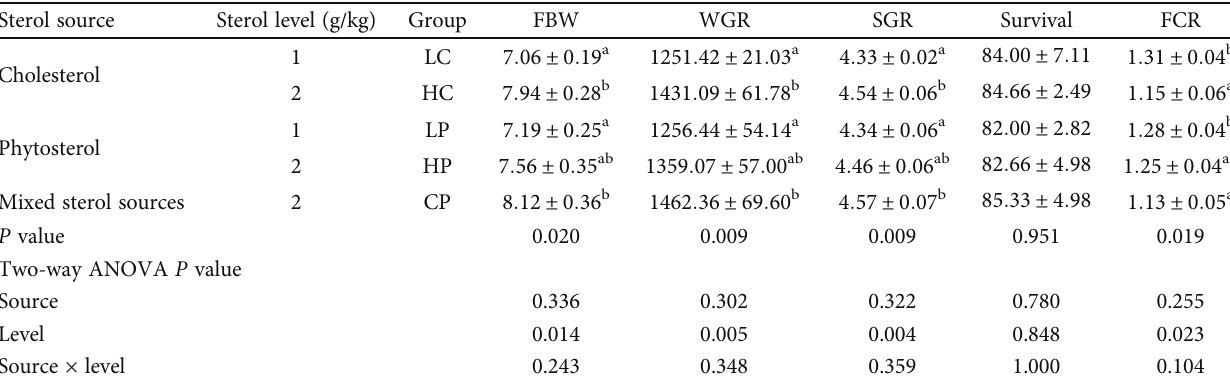
Table 2: Growth performance of shrimp fed di ff erent diets.